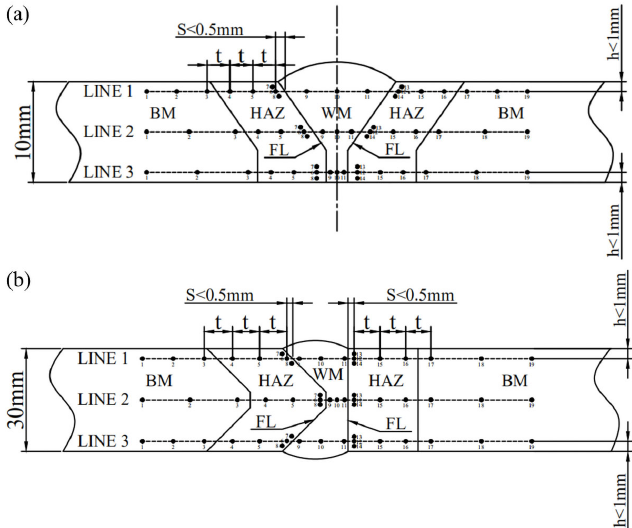
Figure 5. Point distribution of the hardness test of the welded joint: ( a ) thickness of 10 mm; ( b ) thickness of 30 mm.